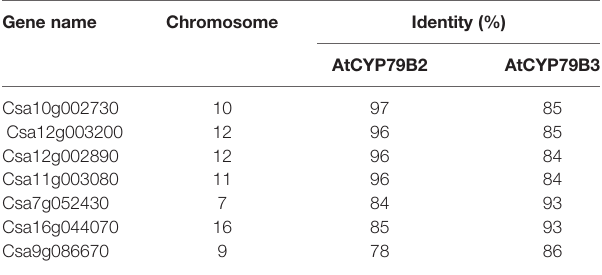
TABLE 1 | Protein sequence identity of Camelina CYP79Bs compared with Arabidopsis